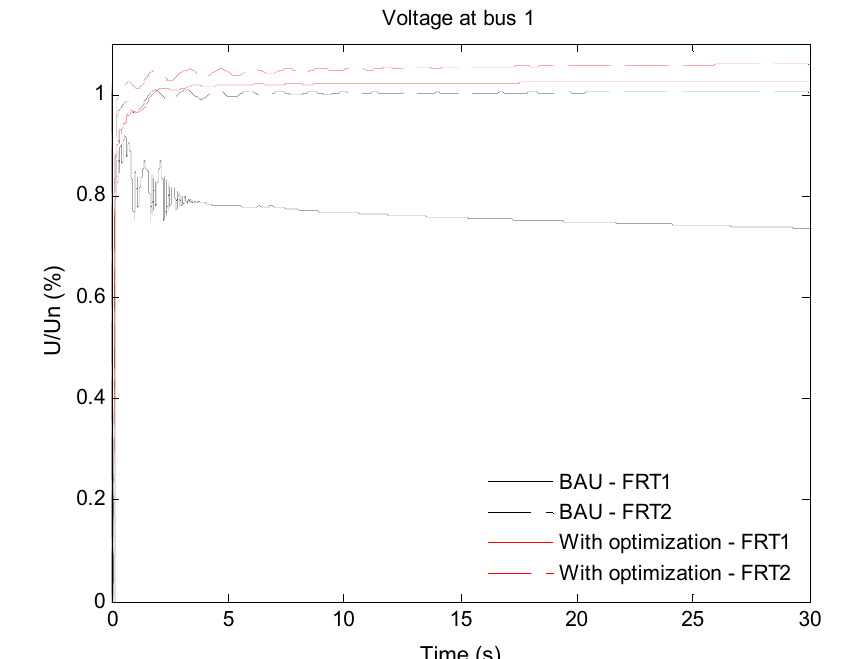
Figure 4. Voltage at connection point of the wind park connected at bus